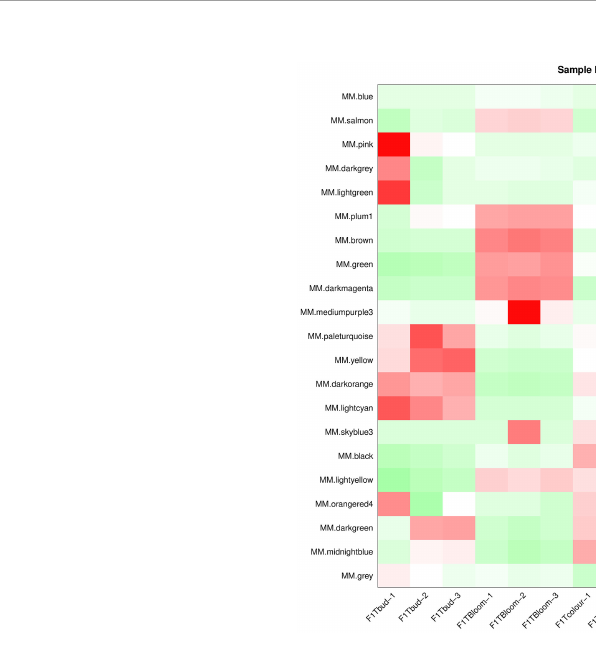
FIGURE 9 Gene expression patterns in different